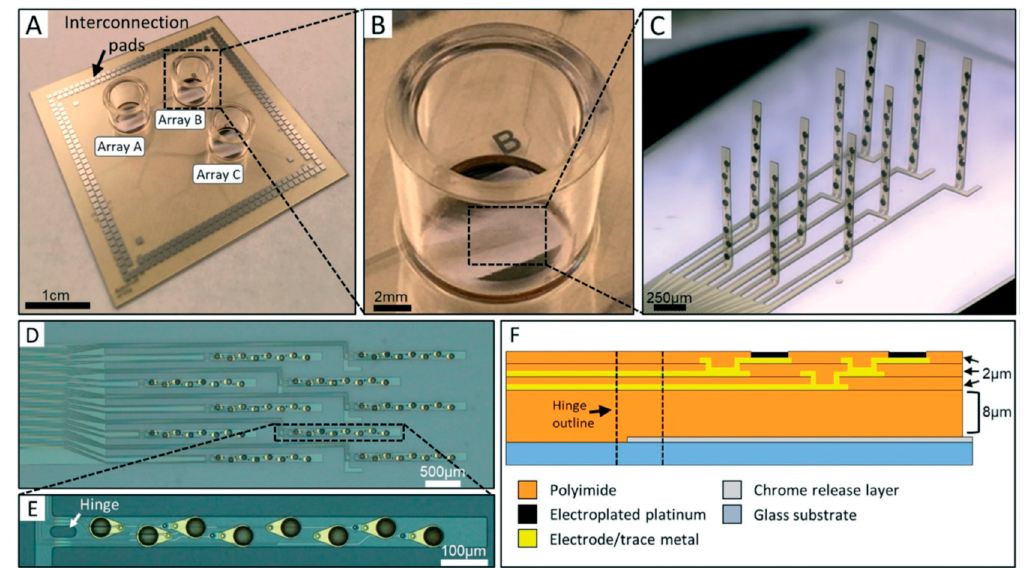
Figure 12. ( A ) Picture of 3D flexible microelectrode array (3DMEA) completed device. ( B ) Close-up image of a single cell culture well. ( C ) Light micrograph of a single 3DMEA post-actuation. ( D ) Brightfield image of one MEA array containing 10 probes and 80 total electrodes prior to actuation. ( E ) Detail of one probe containing 8 electrodes. ( F ) Cross-sectional cartoon showing material stack of microfabricated probe and relative location of hinge (not to scale). Reprinted under Creative Commons Attribution 3.0 Unported Licence [86].